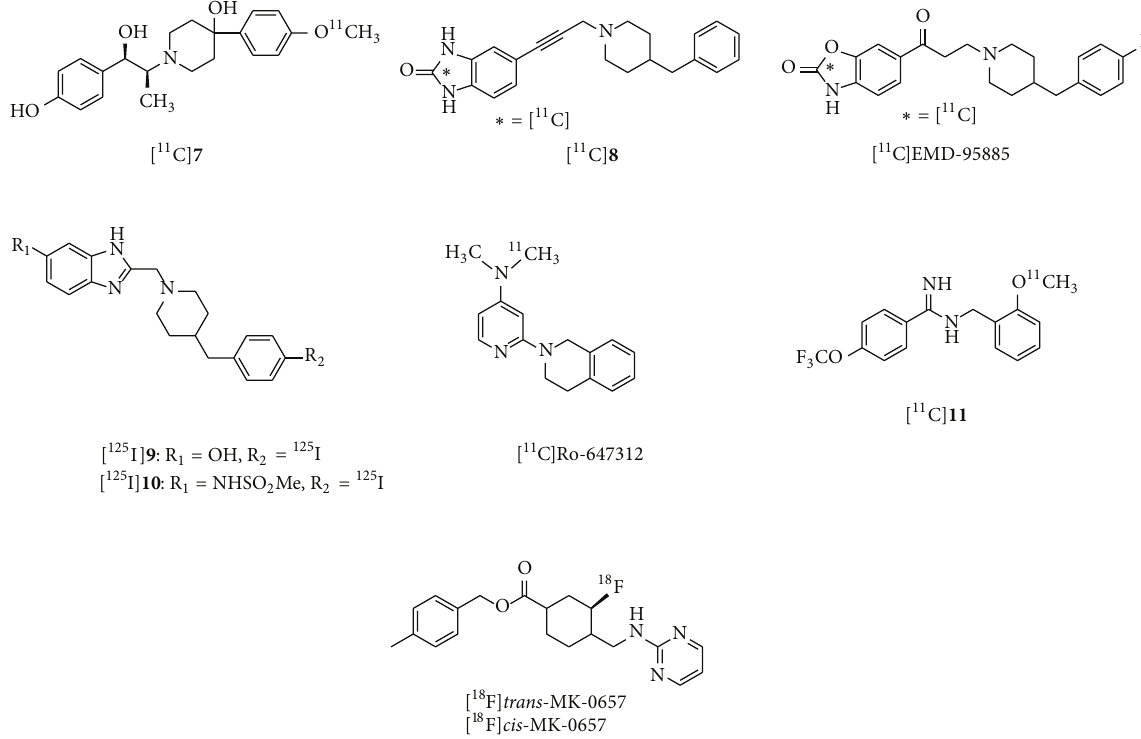
Figure 5: Chemical structure of imaging probes for NR2B negative modulator binding site of